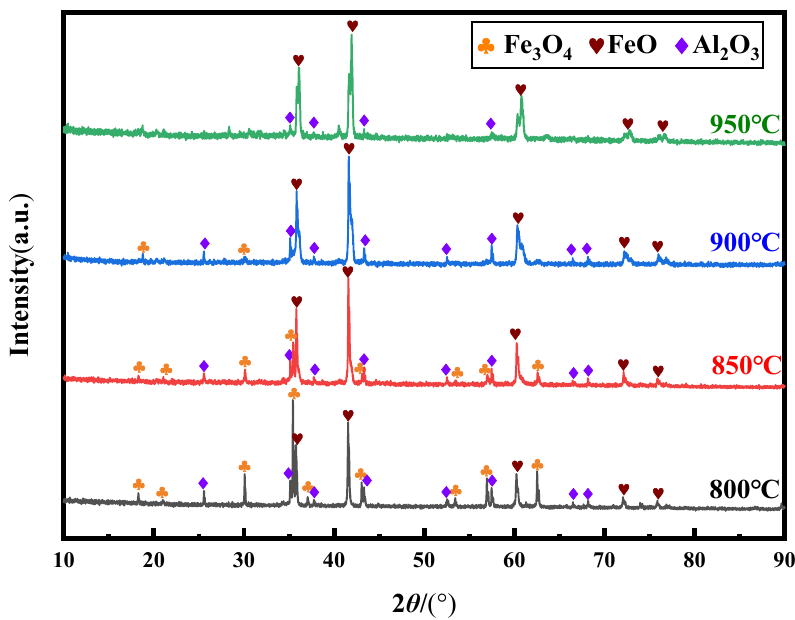
Figure 3. XRD patterns of the products at different electrolysis temperatures.